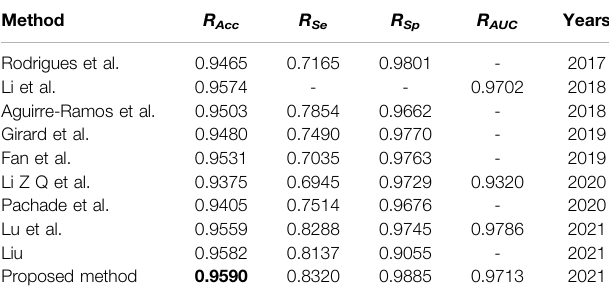
TABLE 1 | Segmentation performance comparison of different algorithms on DRIVE. Method